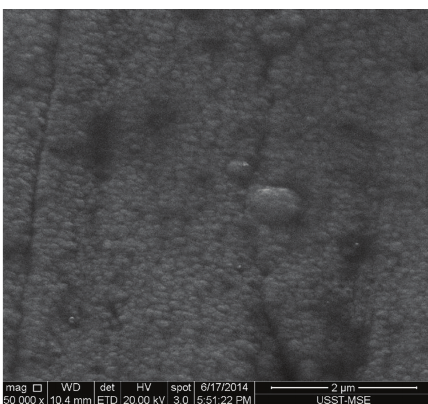
Figure 2: Electron micrographs of Graphit-ic coating.